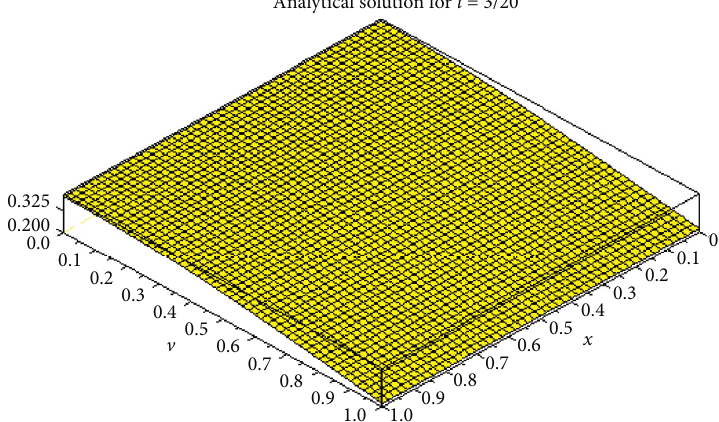
Figure 2: Analytical solution f ( 3/20 ,x, v ) for h � ( 1/10 ) and t � 3/20 ∈ [ 1/10 , 2/10 ) .